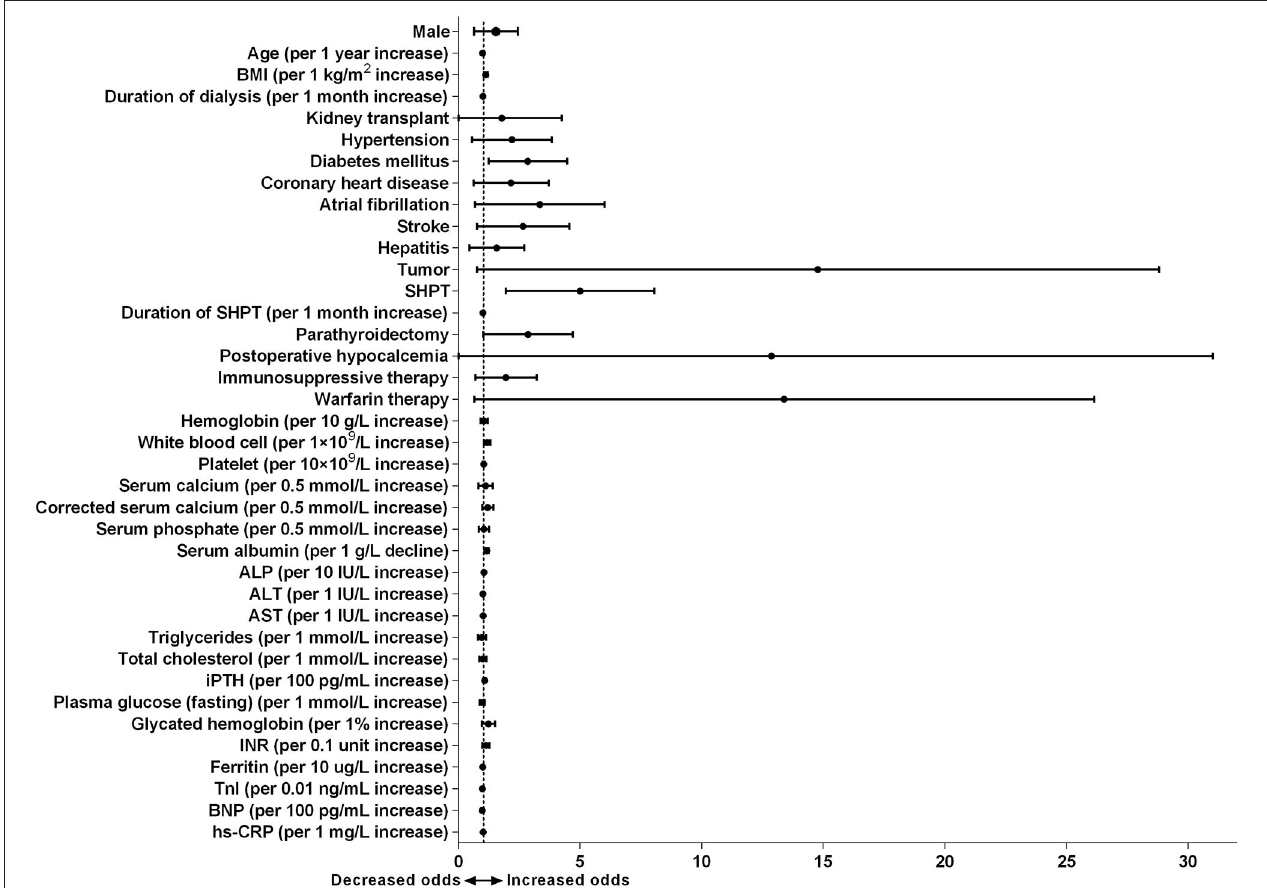
FIGURE 4 | Forest plot of odds ratio of risk factors for calciphylaxis development based on univariate logistic regression analyses. Univariate logistic regression model shows odds ratio (OR) of calciphylaxis development by patient characteristics at the time of diagnosis. Filled circles denote point estimate of OR and error bars represent 95% confidence interval